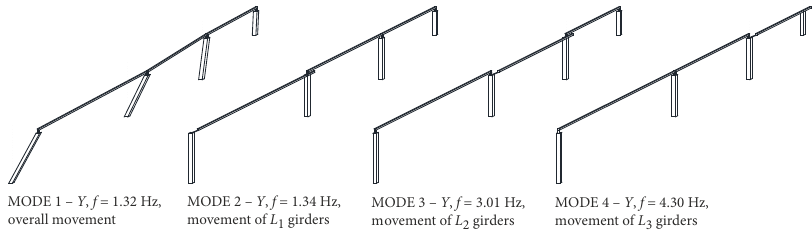
Figure 9. Obtained mode shapes in Y direction in the first Ambient Vibration Survey